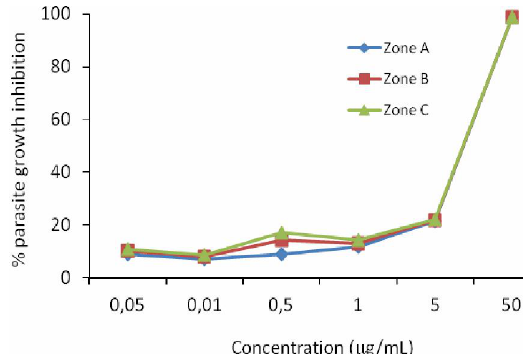
Figure 3. Graph between the concentration of 8-hydroxyisocapnolactone-2  3  -diol versus % inhibition of the growth of chloroquine-resistant P. falciparum (FCR-3) (FCR-3) on the three